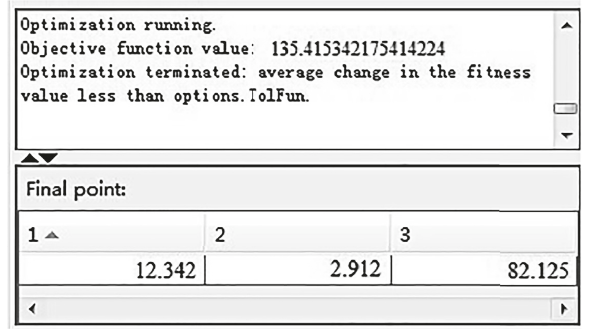
Figure 7: Optimization results of stiffness.